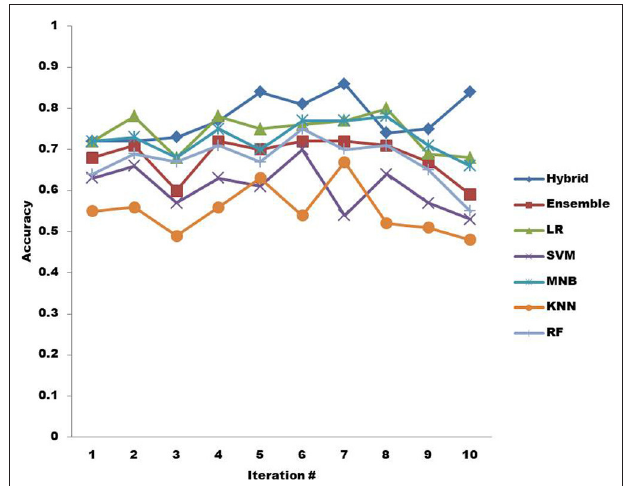
FIGURE 5 | Accuracy of machine learning algorithms with BoW.